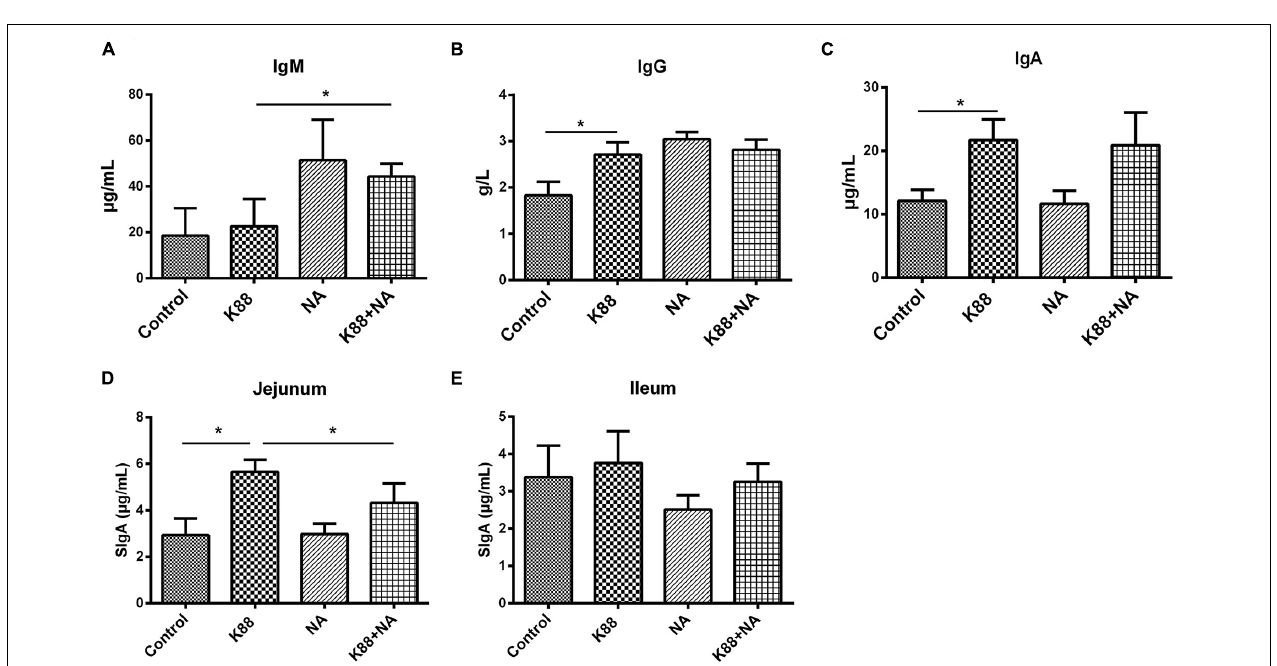
FIGURE 3 | Effects of nicotinic acid on serum levels of immunoglobulins caused by E. coli infection of weaned piglets. The serum levels of immunoglobulins IgM (A) , IgG (B) , IgA (C) , and SIgA in jejunum (D) and ileum (E) mucosa were determined by ELISA. All data are expressed as the mean ± SEM. * P < 0.05.